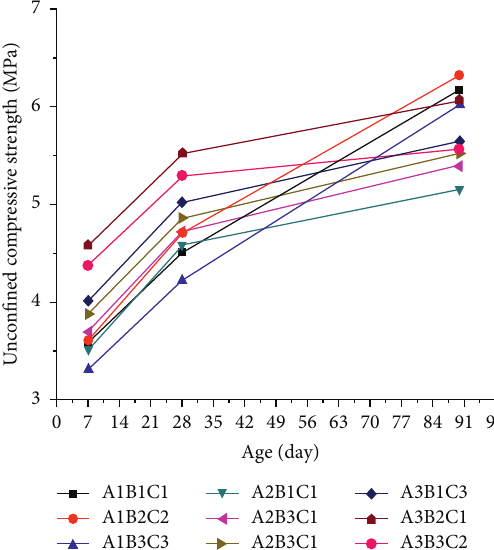
Figure 14: Unconfined compression test